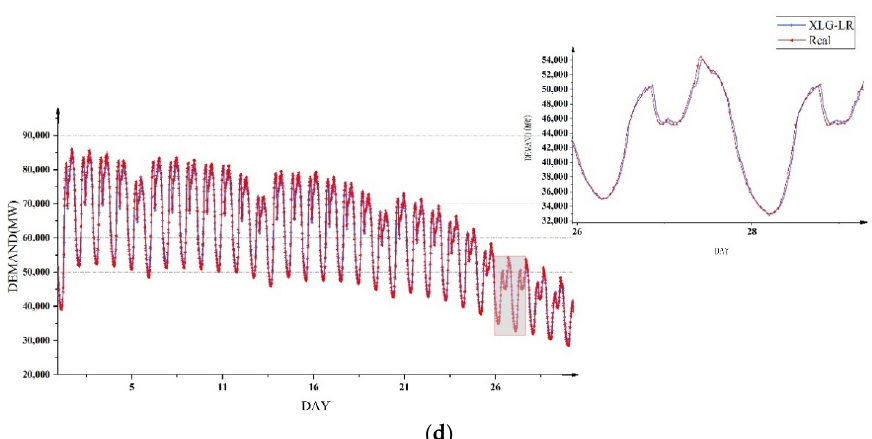
Figure 9. Power Demand Forecasting Results on a Monthly Basis. ( a ) XGB model; ( b ) LGB model; ( c ) GBDT model; ( d ) XLG-LR model. Table 5. Evaluation Index for Power Demand Forecasting of Each Model on a Monthly Basis.